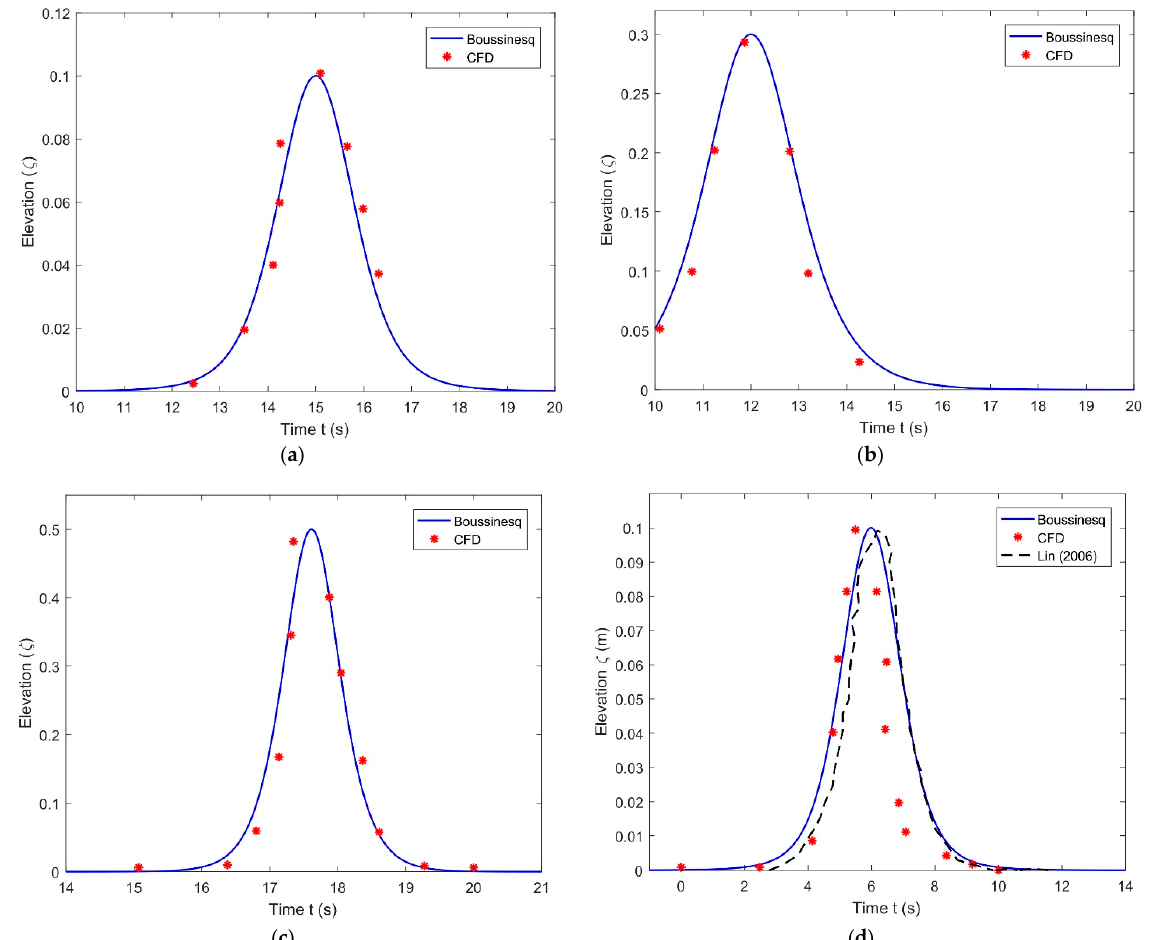
(see [31]) versus time t (s).